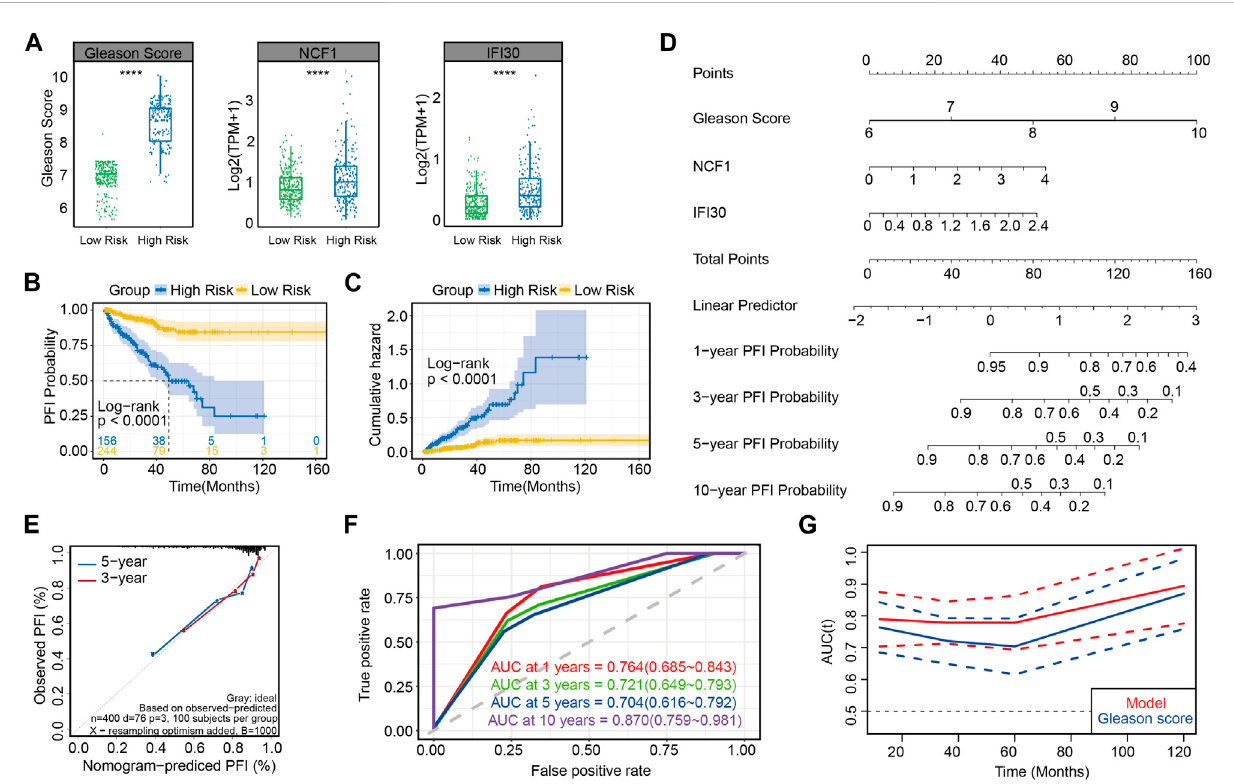
FIGURE 4 AccuracyforpredictingPCaprognosisbyusingthisriskmodelinthetrainingset (A) GleasonscoresandtheexpressionofNCF1andIFI30indifferent riskgroups; (B) PFIcurvesbetweentworiskgroupsinthetraining set; (C) Cumulativehazardanalysisoftworiskgroupsinthetrainingset; (D) Nomogram for predicting the progression-free rate of PRAD patients based on the novel signature; (E) Calibration curve showing that the predictive PFI fi t the